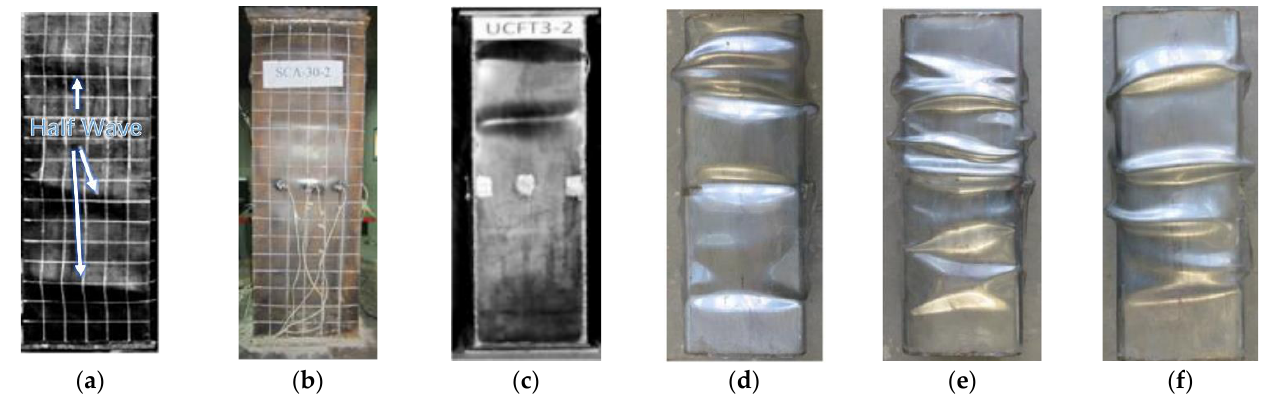
Figure 5. The buckling forms of the side plate of the steel tube in rectangular CSFT in existing studies.